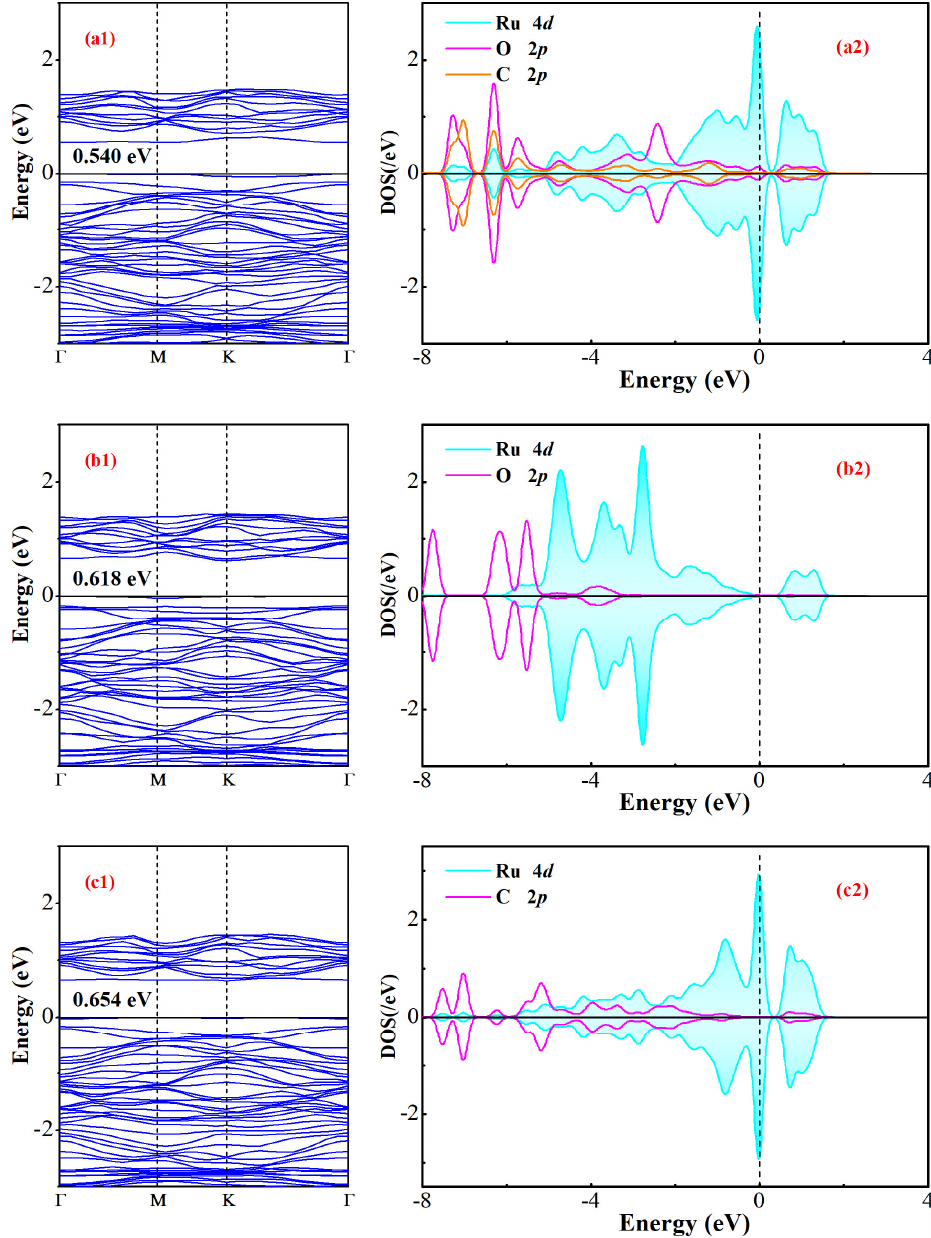
Figure 5. BS and orbital DOS of ( a1 , a2 ) C 3 H 4 O, ( b1 , b2 ) C 3 H 6 O and ( c1 , c2 ) C 5 H 8 systems.